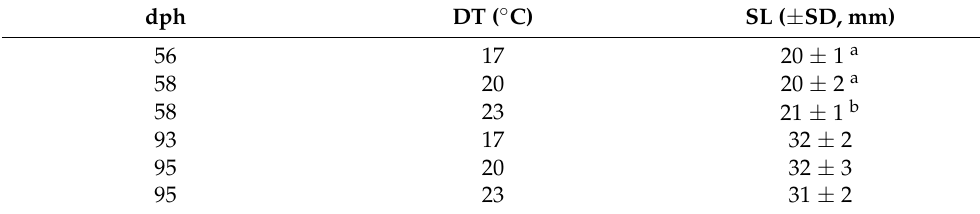
Table 1. Characteristics of the samples taken from the experimental populations. DT, developmental temperature. dph, days post-hatching. SL, average standard length. Each sample consisted of 30 fish. Different superscripts (a, b) indicate significant differences among the different groups in the same developmental period ( p < 0.05,